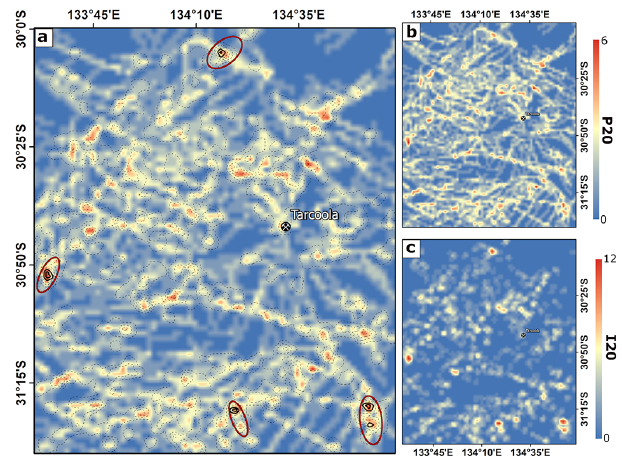
Figure 12. (a) Targeting map derived from “surface manual” com- bined with the structural interpretation (Fig. 2a). (b) Lineament den- sity map (P20). (c) Intersection density map (I20). Potential target- ing areas are indicated by red ellipses.